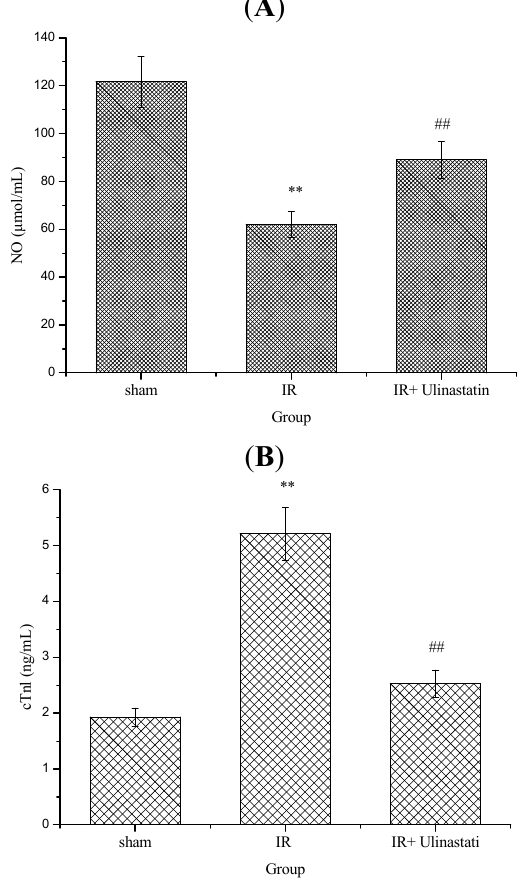
Figure 3. Effect of ulinastatin on serum NO and nTnl levels in three